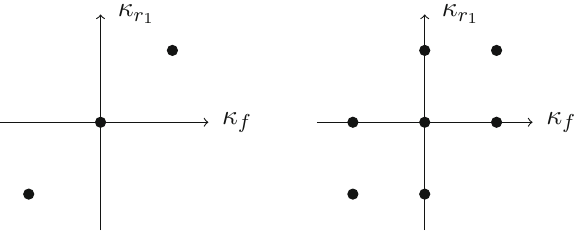
Fig. 4 Same as Fig. 2, now in the case of the asymmetric prescriptions for a single process with factorization scale κ f and renormalization scale κ r . We display the 3-point (left) and 7-point (right) prescriptions, defined in the